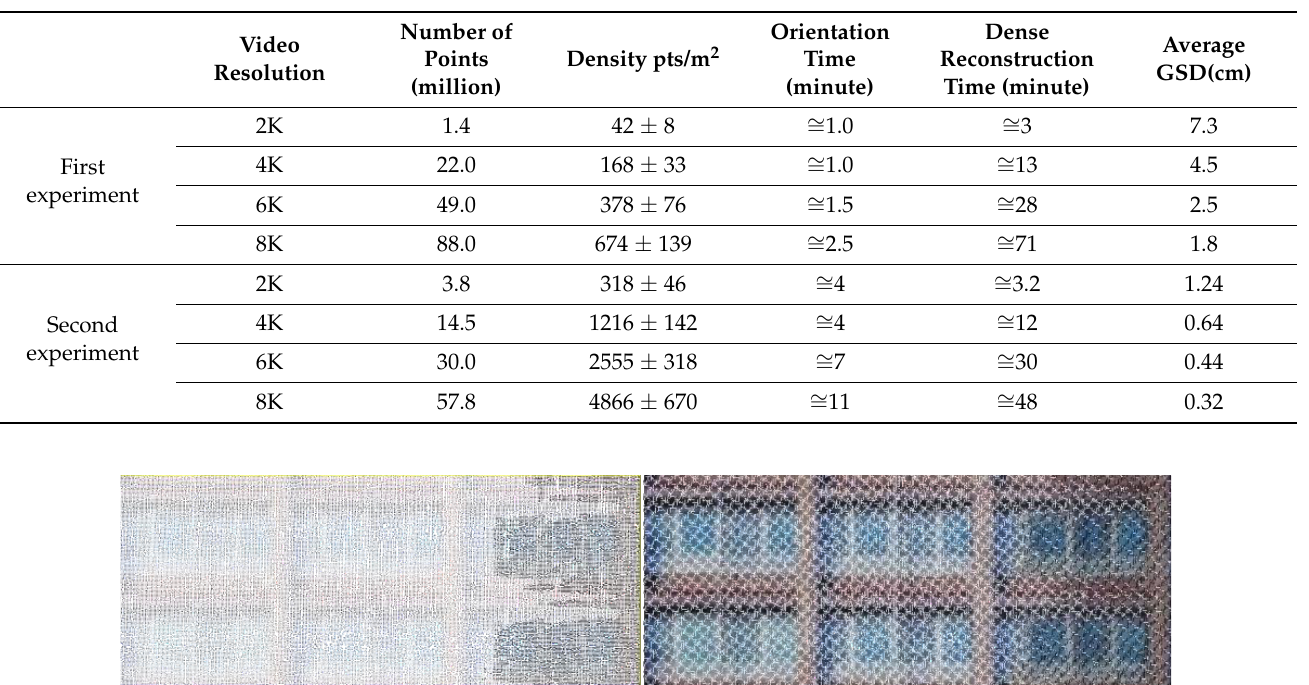
Table 5. Summary of results.